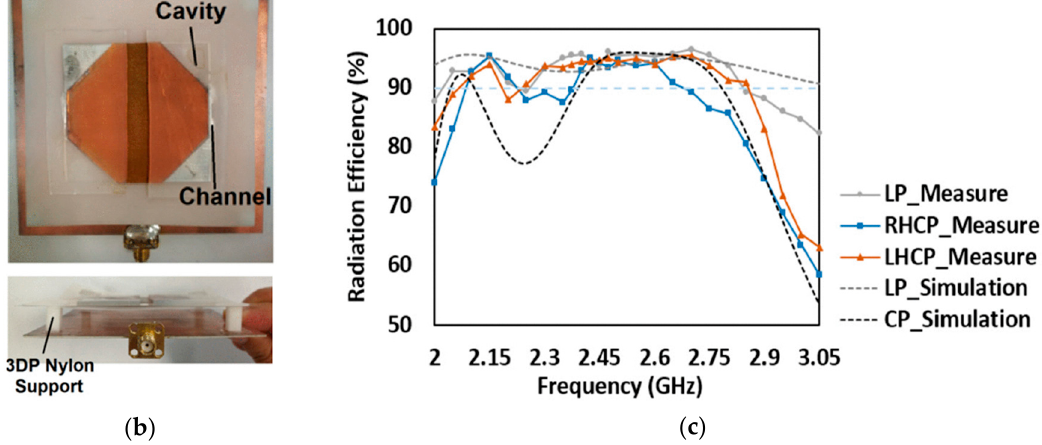
Figure 3. ( a ) Fabrication process of the patch antenna using soft-lithography. ( b ) Front and top view of the fabricated antennas. ( c ) Comparison of antenna’s simulated and measured radiation efficiency [45]. Abbreviations: PET, polyethylene terephthalate.